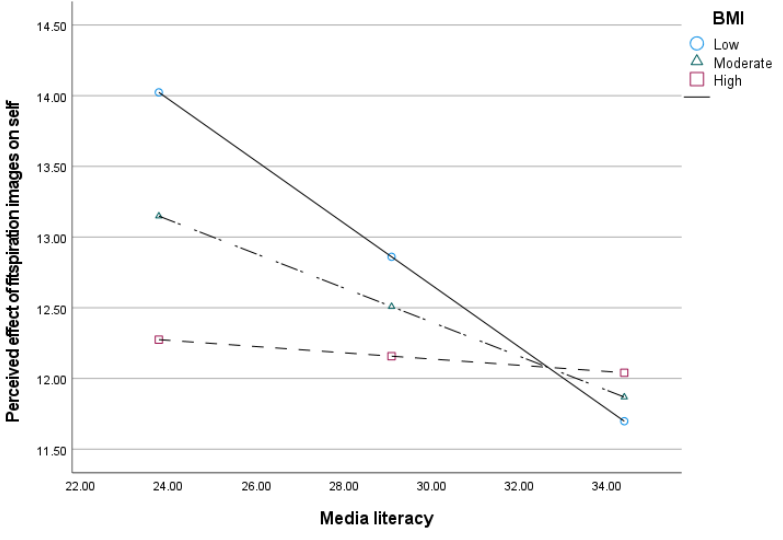
Figure 1. Interaction effect between media literacy and BMI on the perceived effect of fitspiration images on self.